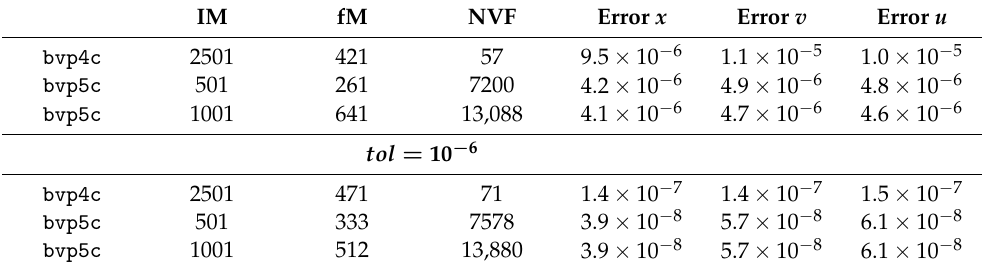
Table 3. Nonlinear Mass spring, initial mesh (IM) with 501, 1001 and 2501 equidistant points and T = 2 × 10 4 : final mesh (fM), total number of vectorized function evaluation (NVF) and mixed errors for x , v , u